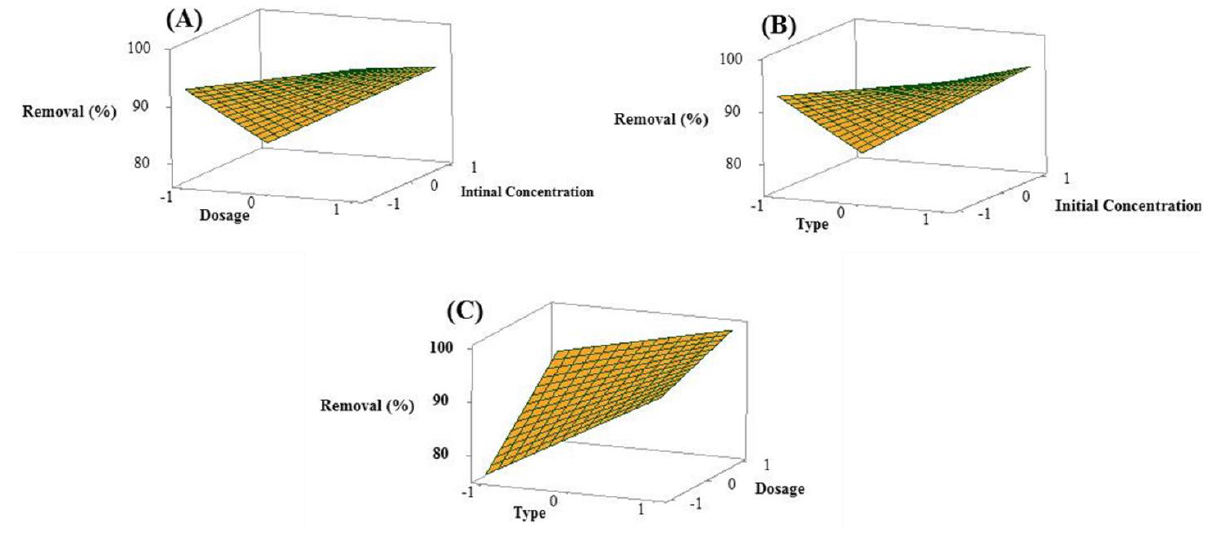
Figure 13. Surface graph of dye removal showing interaction of ( A ) dosage and initial concentration, ( B ) type and initial concentration, and ( C ) type and dosage.